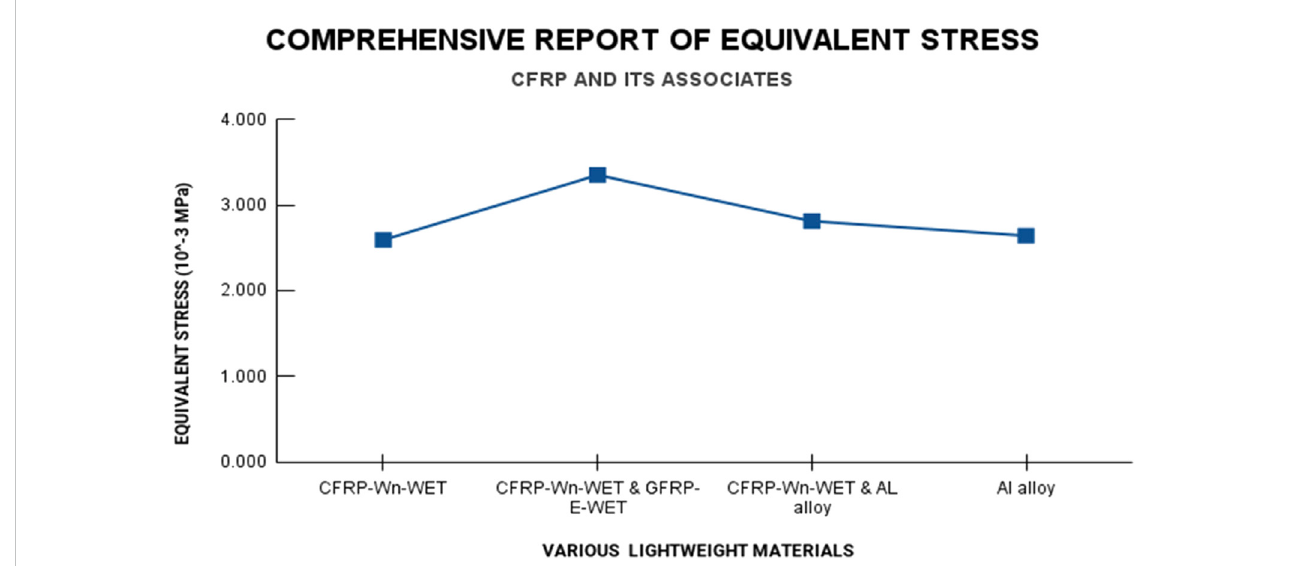
FIGURE 22 Equivalent stress on full fuselage of RUAV with CFRP and its associate materials.